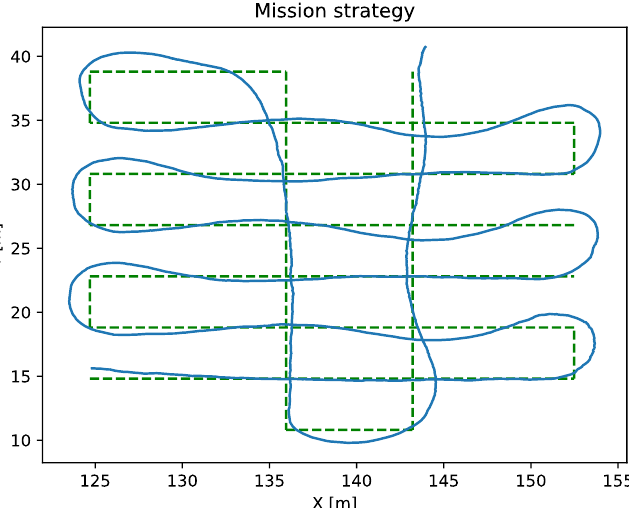
Figure 10. The green dashed line represents the programmed mission path. The blue line shows the navigation route achieved by the ASV.